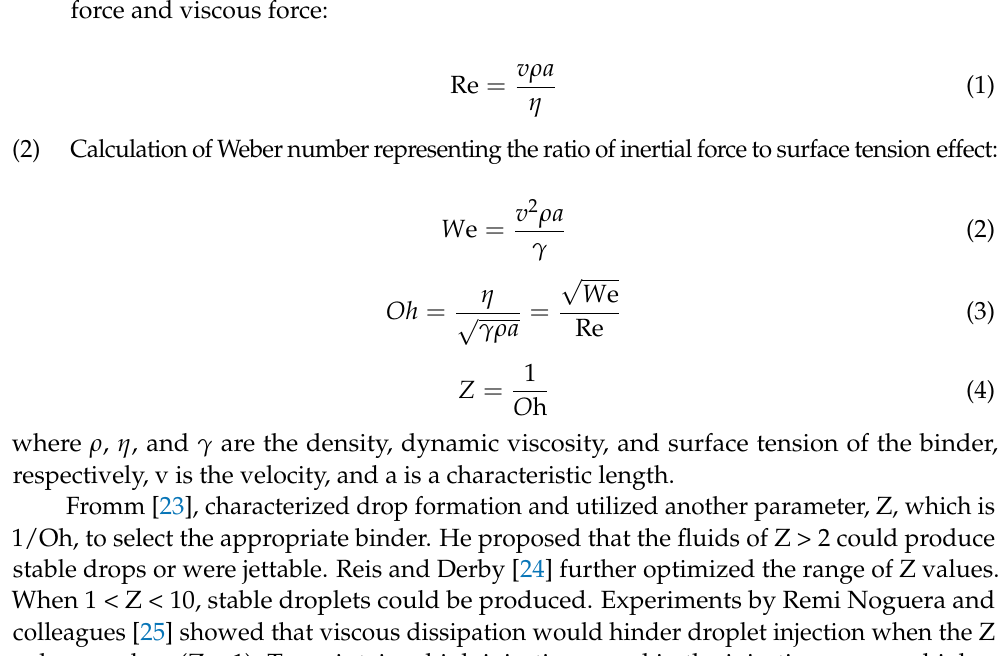
Calculation of Reynolds number to measure the relative magnitude of fluid inertia force and viscous force: